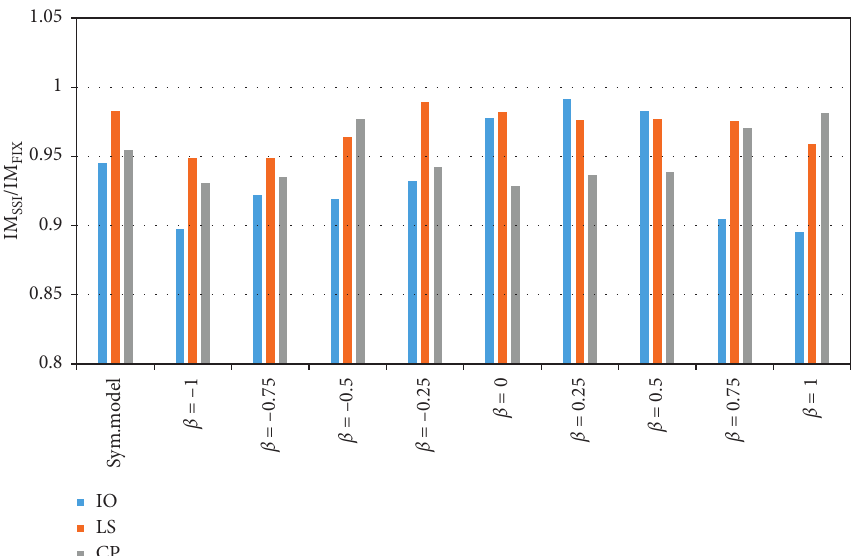
Figure 12: Comparison of the IM capacities of fixed- and flexible-base models.